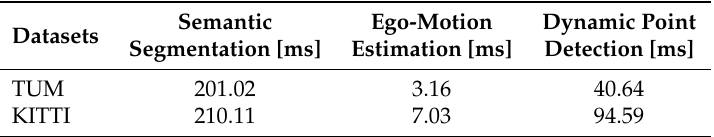
Figure 12. ( a–d ) Comparison of the motion trajectories of DM-SLAM with the ground-truth trajectories for the 02, 04, 05, and 09 sequences of the KITTI dataset. The dotted line represents the ground-truth trajectory. The degree of warmth and coldness of the color on the dotted line represents the magnitude of the error. Table 4. DM-SLAM average computational time (unit: ms) of different